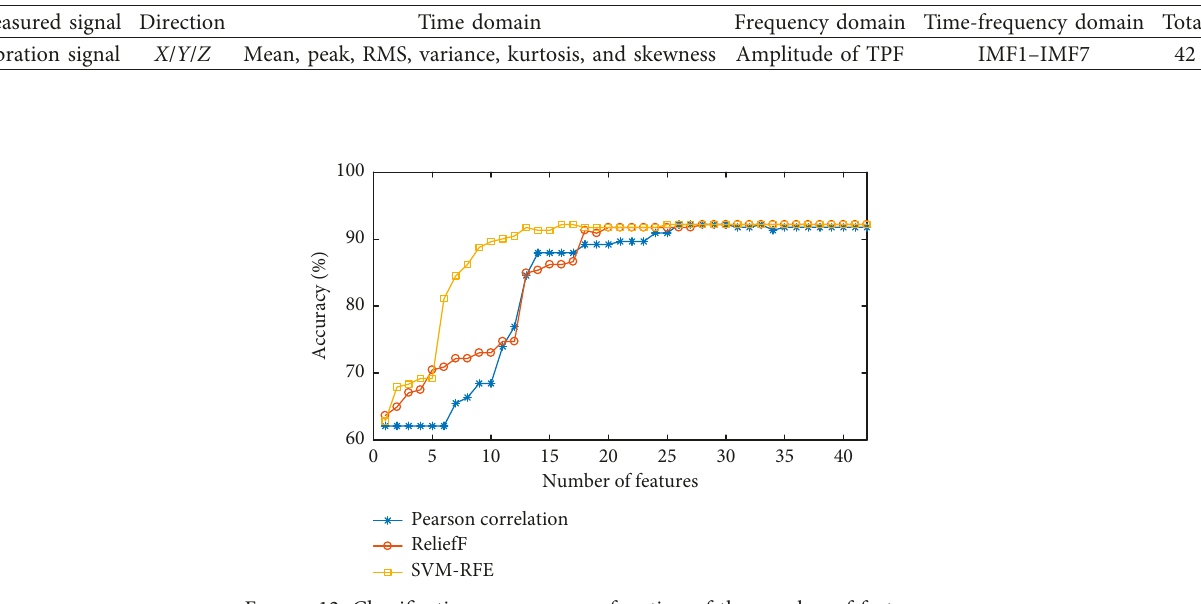
Figure 11: Energy percentage of IMFs of vibration signals: (a) X -directional vibration signals, (b) Y -directional vibration signals, and (c) Z -directional vibration signals. Table 5: Extracted signal features.